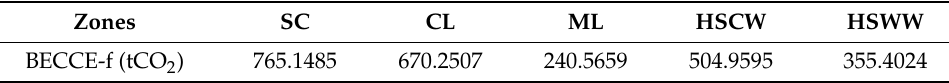
Table 2. BECCE-f (tCO 2 ) of the 5 zones.